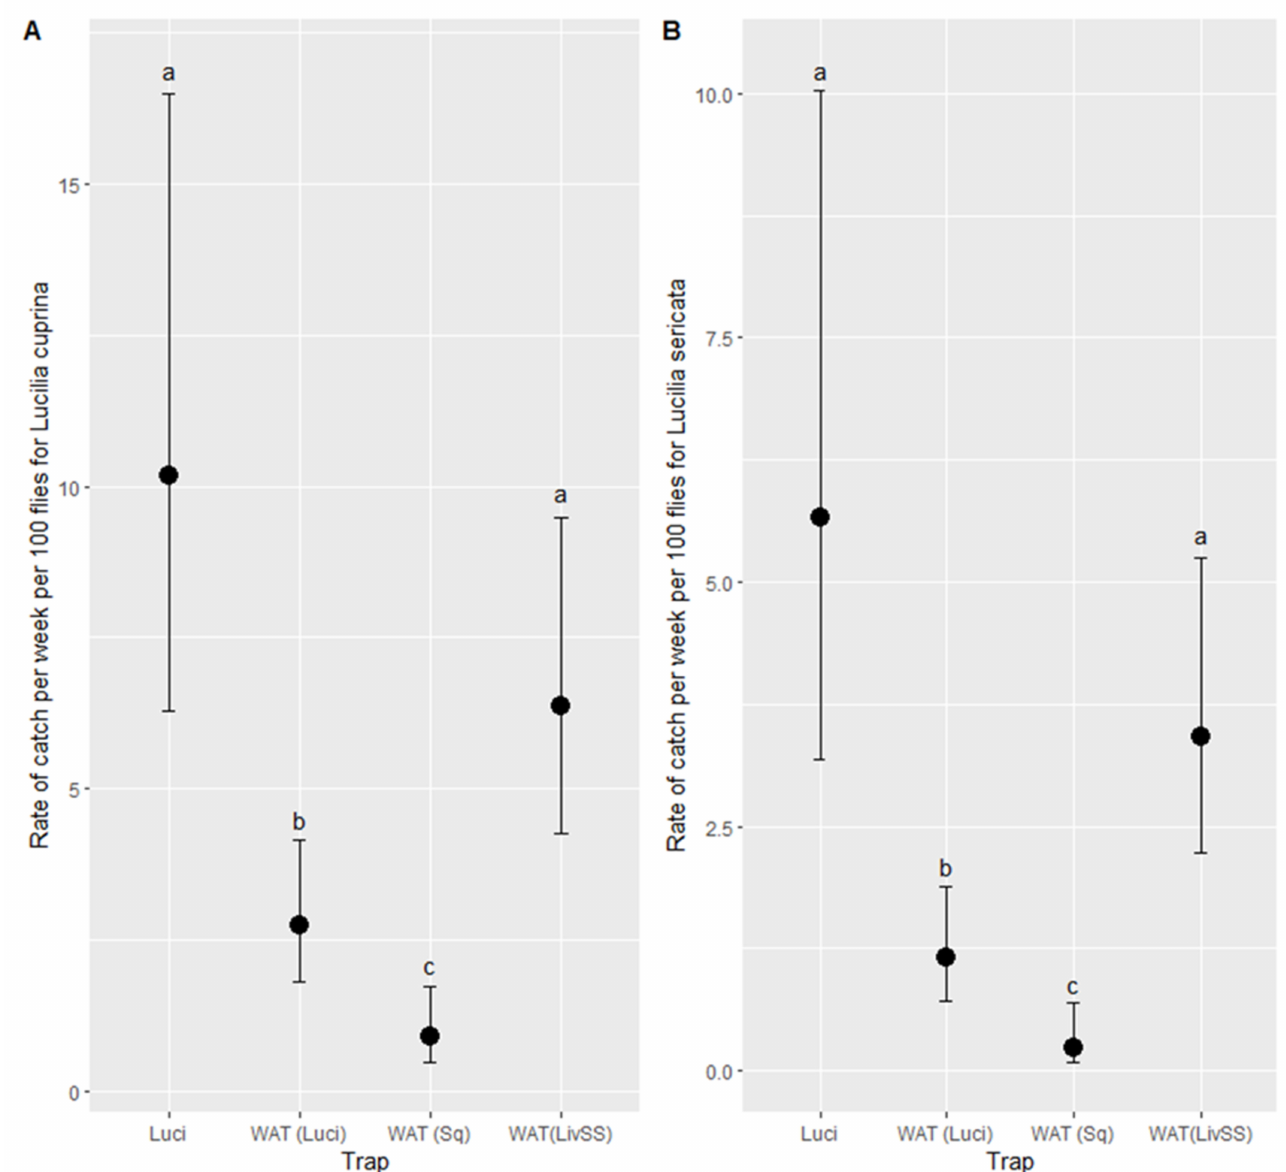
Figure 10. The estimated rate per week of the catch of Lucilia cuprina ( A ), adjusting for the effect of rainfall and Lucilia sericata ( B ). Trap types with differing letters (a, b, and c), within target species, are significantly different based on a Tukey comparison of least square means ± standard error ( p < 0.05). LuciTrap with LuciLure A, B and C (Luci); Western Australian Trap with squid (WAT (Sq)), Western Australian Trap with LuciLure A, B and C (WAT (Luci)); and Western Australian Trap with sheep liver and sodium sulphide (WAT